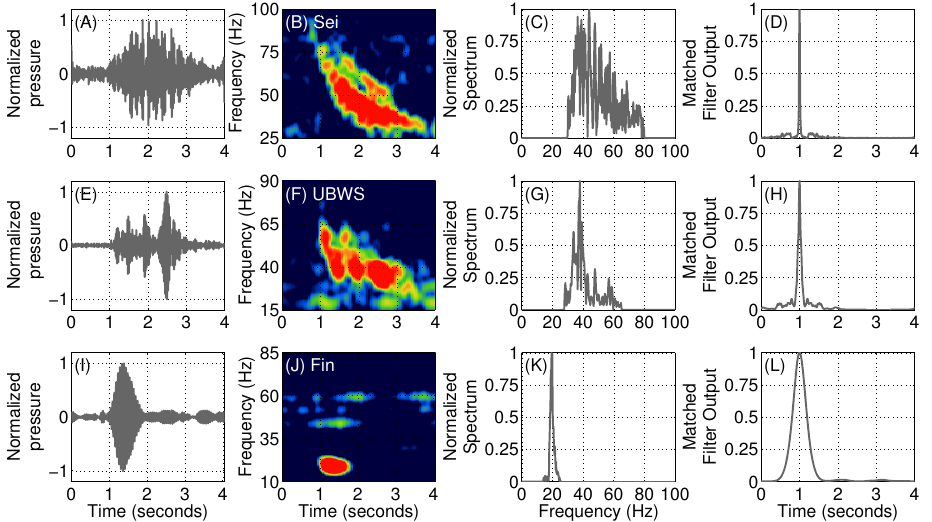
Figure 8. Example vocalizations and corresponding matched filter outputs for ( A – D ) sei whale, ( E – H ) unidentified baleen whale species and ( I – L ) fin whale. Sub-plots ( A , E , I ) show the beamformed pressure-time series for each species. The corresponding spectrograms (0.26-s length, 75% overlap) are shown in ( B , F , J ), respectively. Sub-plots ( C , G , K ) show the normalized spectrum for each vocalization over a time-window encompassing 90% of the total energy. After matched filtering each vocalization signal with a corresponding replica generated following the approach described in Appendix B of [22], the compressed pulse signals are plotted in ( D , H , L ),